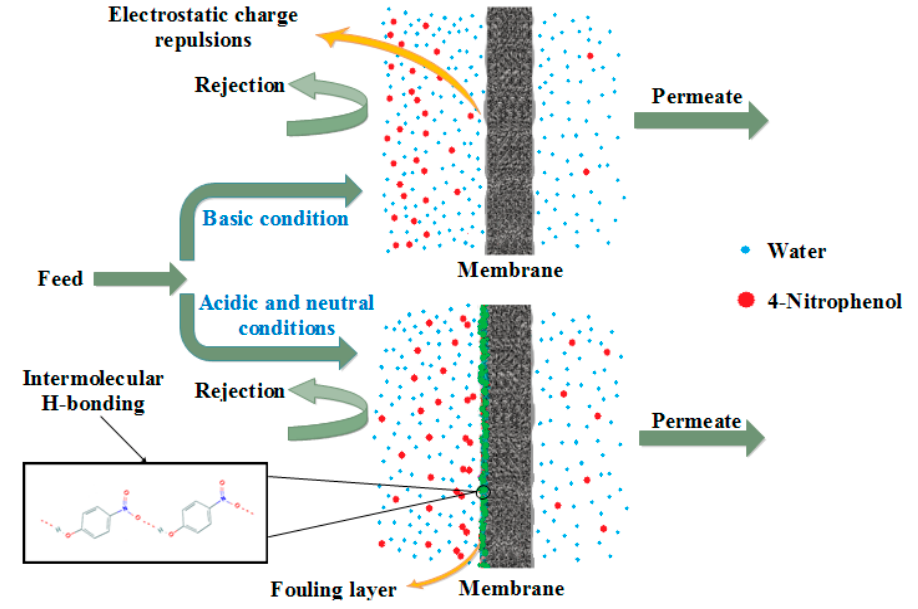
Figure 7. Impact of the pH conditions on the permeation and retention characteristics of the mem ‐ branes.